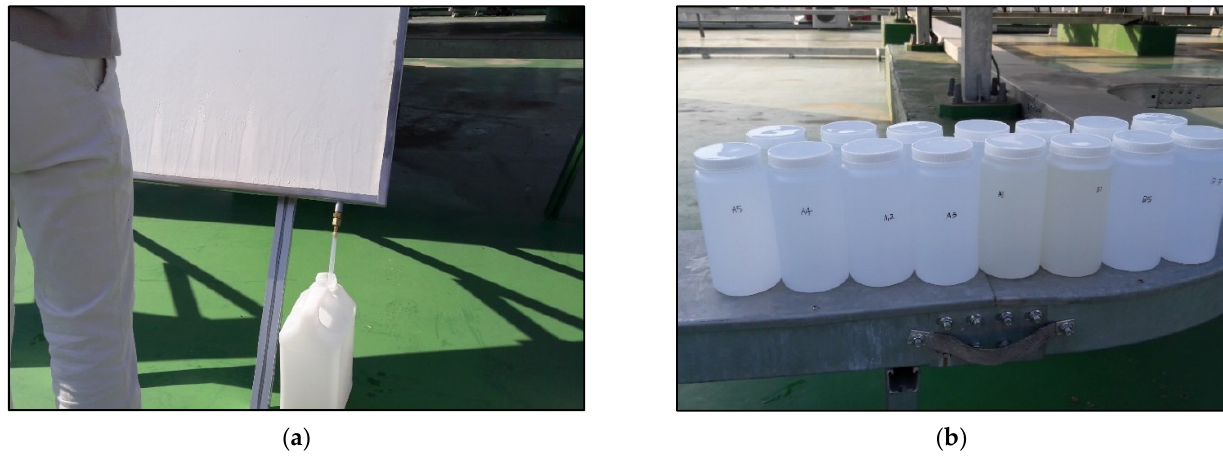
Figure 12. Collecting process and storage procedure of washing water. ( a ) collecting process of washing water; ( b ) collected washing water in seperate bottles. Table 10. Washing water field test results of photocatalytic